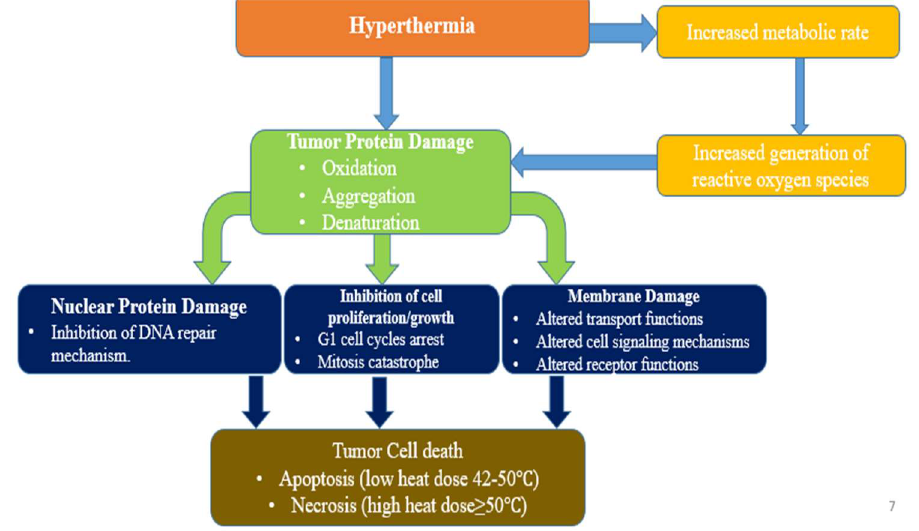
Figure 1. Mechanism of hyperthermia therapy of cancer cells.